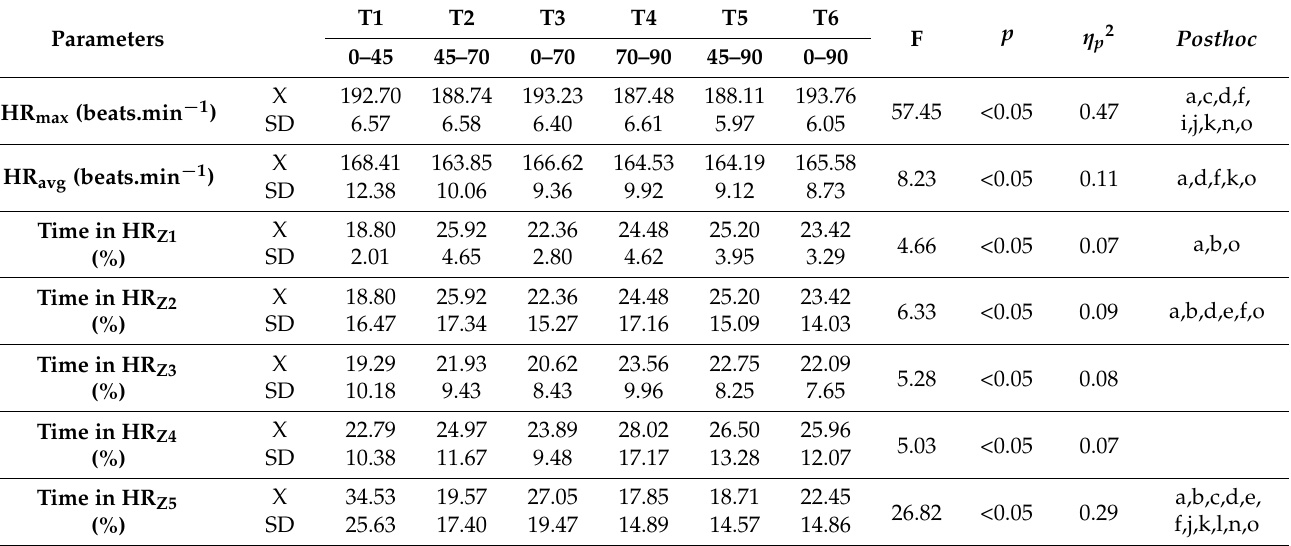
Table 2. Comparison of internal load parameters of the different match time